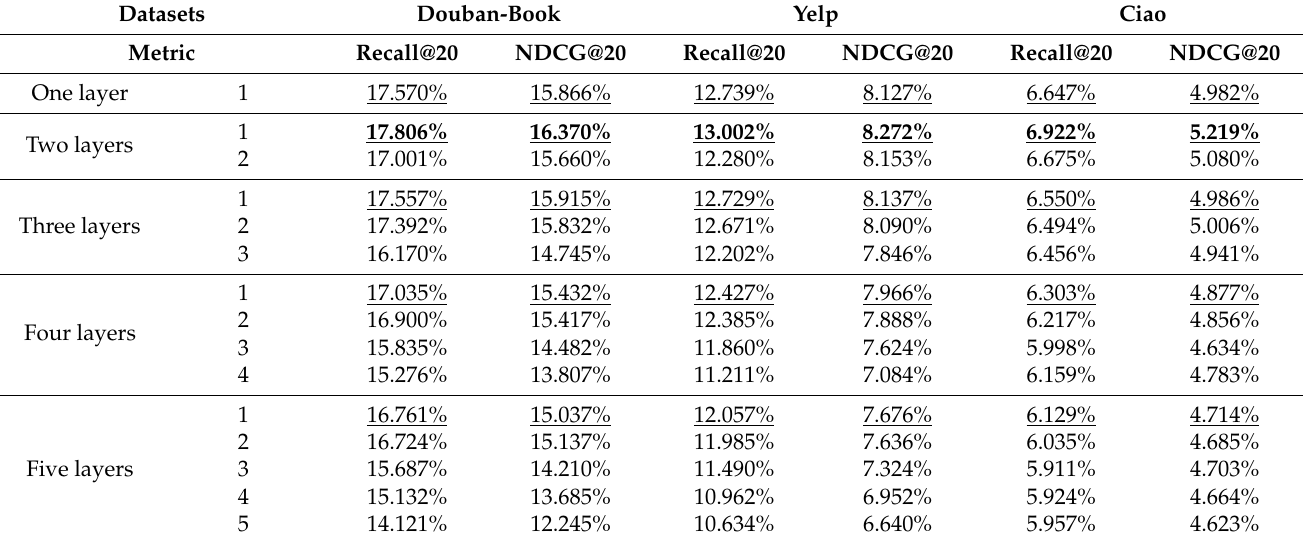
Table 6. Influence of the depth of